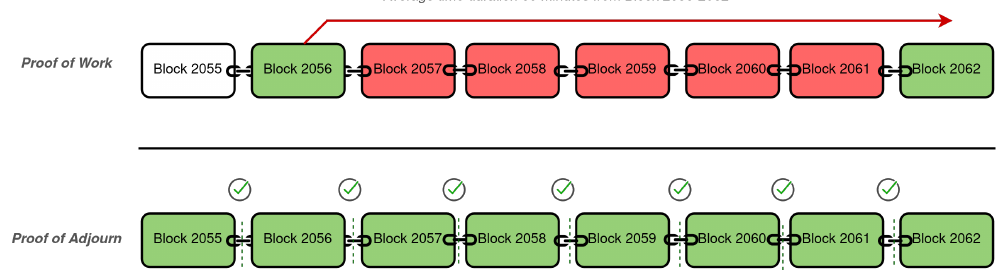
Figure 9. The top chain shows an example where new added blocks in PoW need to wait for 6 block confirmation. The chain at the bottom uses PoAj and do not need to wait for any confirmation block.